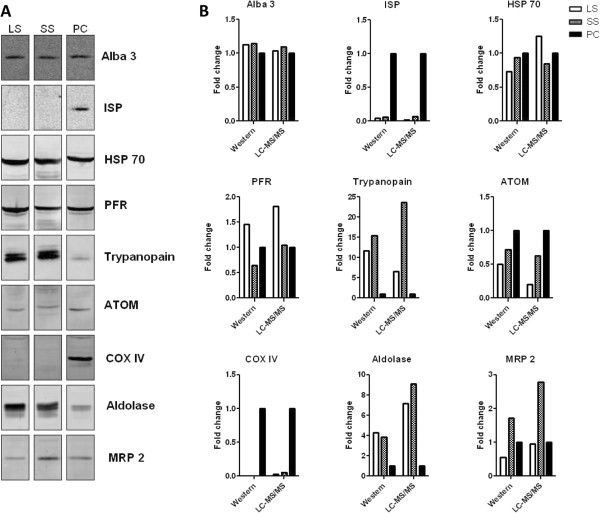
Comparison of mass spectrometry and western blotting for protein abundance-changes during development of T. brucei.  Protein extracts used for mass spectrometry were probed using nine different antibodies. (A) Western blots using total cell extracts of long slender (LS), short stumpy (SS) and procyclic (PC). Antibodies used: Alba 3, iron sulfur protein (ISP), heat shock protein 70 (HSP 70), paraflagellar rod protein (PFR), trypanopain, archaic translocase of the outer mitochondrial membrane (ATOM), cytochrome oxidase subunit IV (COX IV), Aldolase and mitochondrial RNA binding protein 2 (MRP2). (B) Histograms of the fold-change measured by western blotting and mass spectrometry.